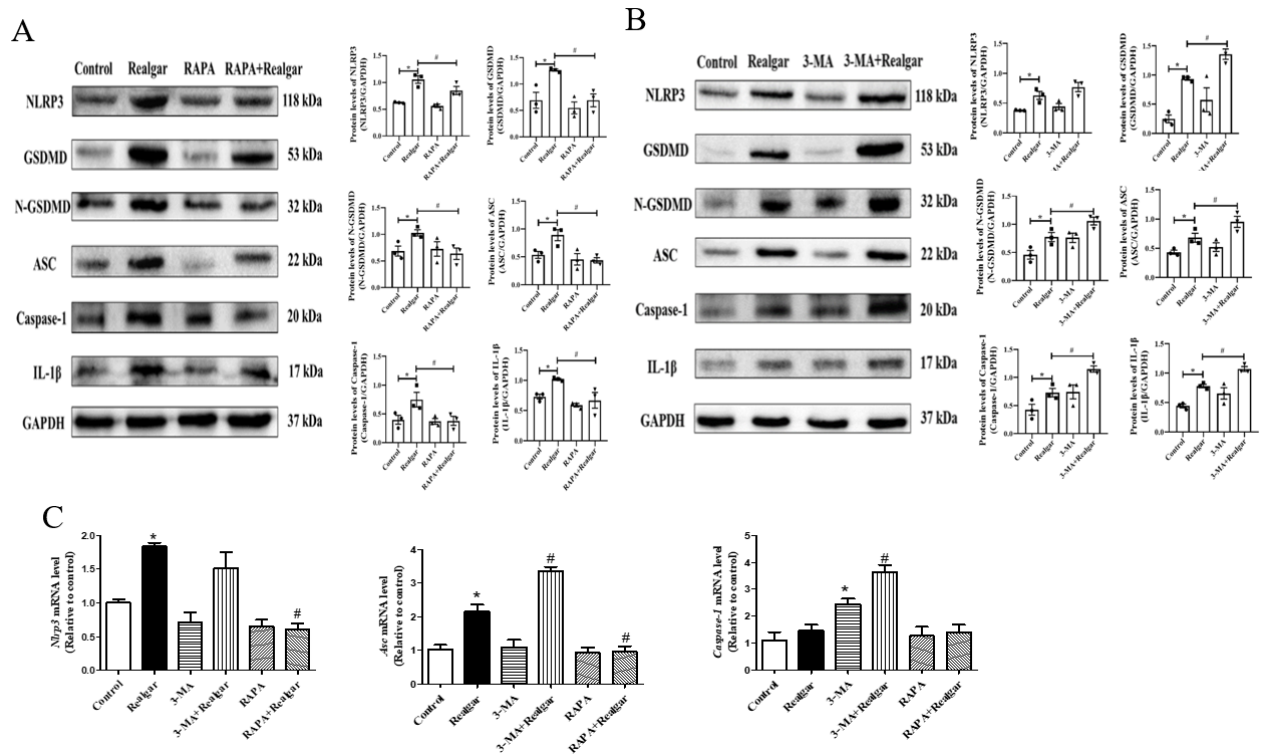
Figure 4. Autophagy retard realgar induced NLRP3 inflammasome activation in mouse livers. ( A ) Representative Western blots and quantitative analysis of the expressions of NLRP3 inflammasome-related proteins in RAPA treated groups. The gray value of the bands was normalized to GAPDH ( n = 3). ( B ) Representative Western blots and quantitative analysis of the expressions of NLRP3 inflammasome-related proteins in 3-MA treated groups. The gray value of the bands was normalized to GAPDH ( n = 3). ( C ) The relative mRNA levels of Nlrp3 , Asc and Caspase-1 were evaluated by RT-qPCR and normalized the data to Gapdh ( n = 3). Data are presented as mean ± SEM. * p < 0.05, compared with control group; # p < 0.05, compared with realgar-treated